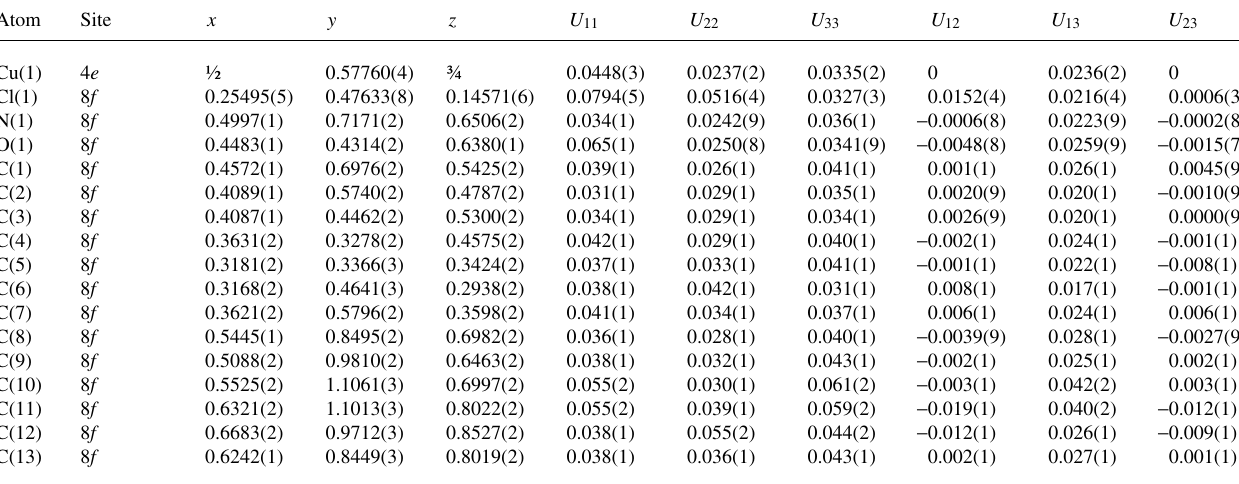
Table 3. Atomic coordinates and displacement parameters (in Å 2 )